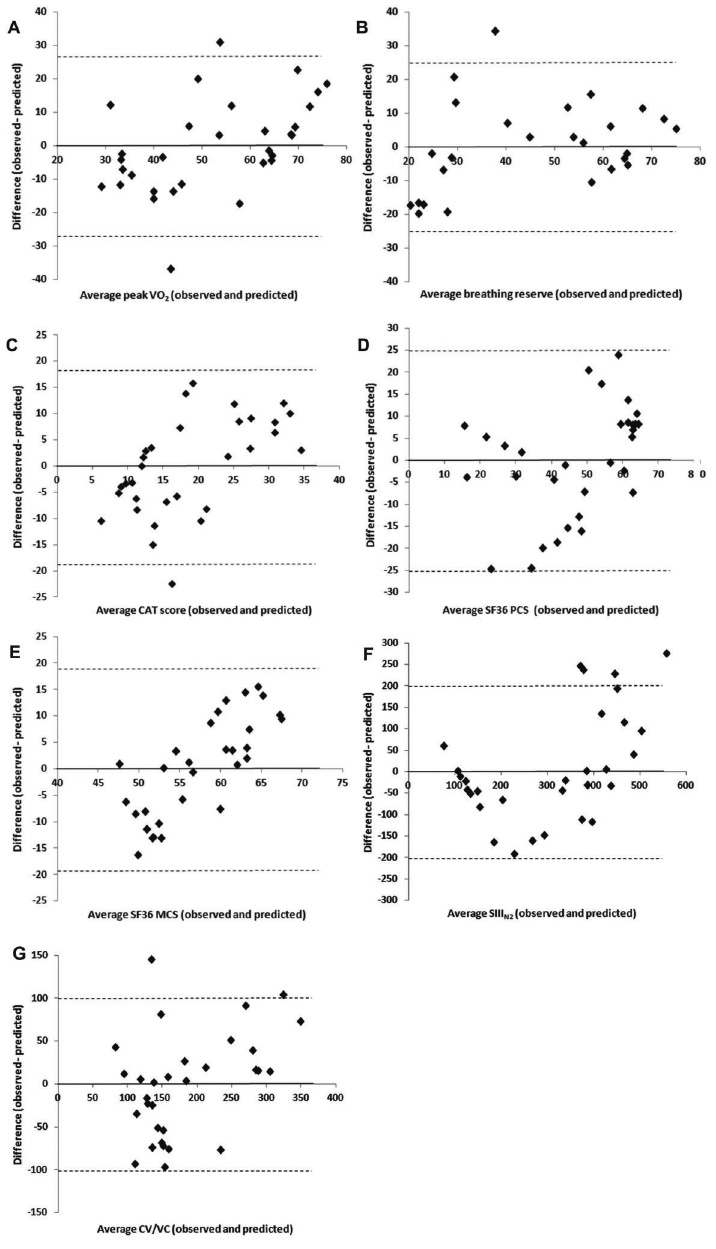
Figure 3. Limits of agreement plots of the averaged values and the differences (observed - predicted values). A , Analysis of the multiple linear regression models for peak oxygen uptake (peak VO 2 ); B , breathing reserve; C , chronic obstructive pulmonary disease assessment test (CAT); D, 36-Item Short Form Health Survey- physical component summary (SF36 PCS); E , 36-Item Short Form Health Survey-mental com- ponent summary (SF36 MCS); F , phase III